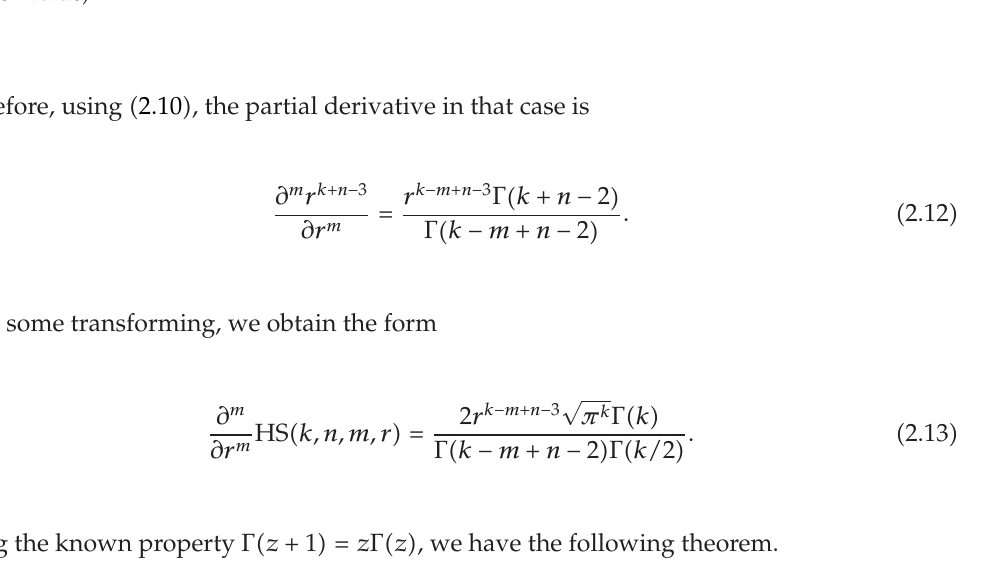
Figure 2: The submatrix HS (cid:2) k,n,r (cid:3) of the function for k ∈ − 3 , − 2 ,..., 5 and n ∈ − 2 , − 1 ,..., 6 with six highlighted characteristic functions (cid:2) undef. are undefined values, predominately singular ±∞ of this function value (cid:3)